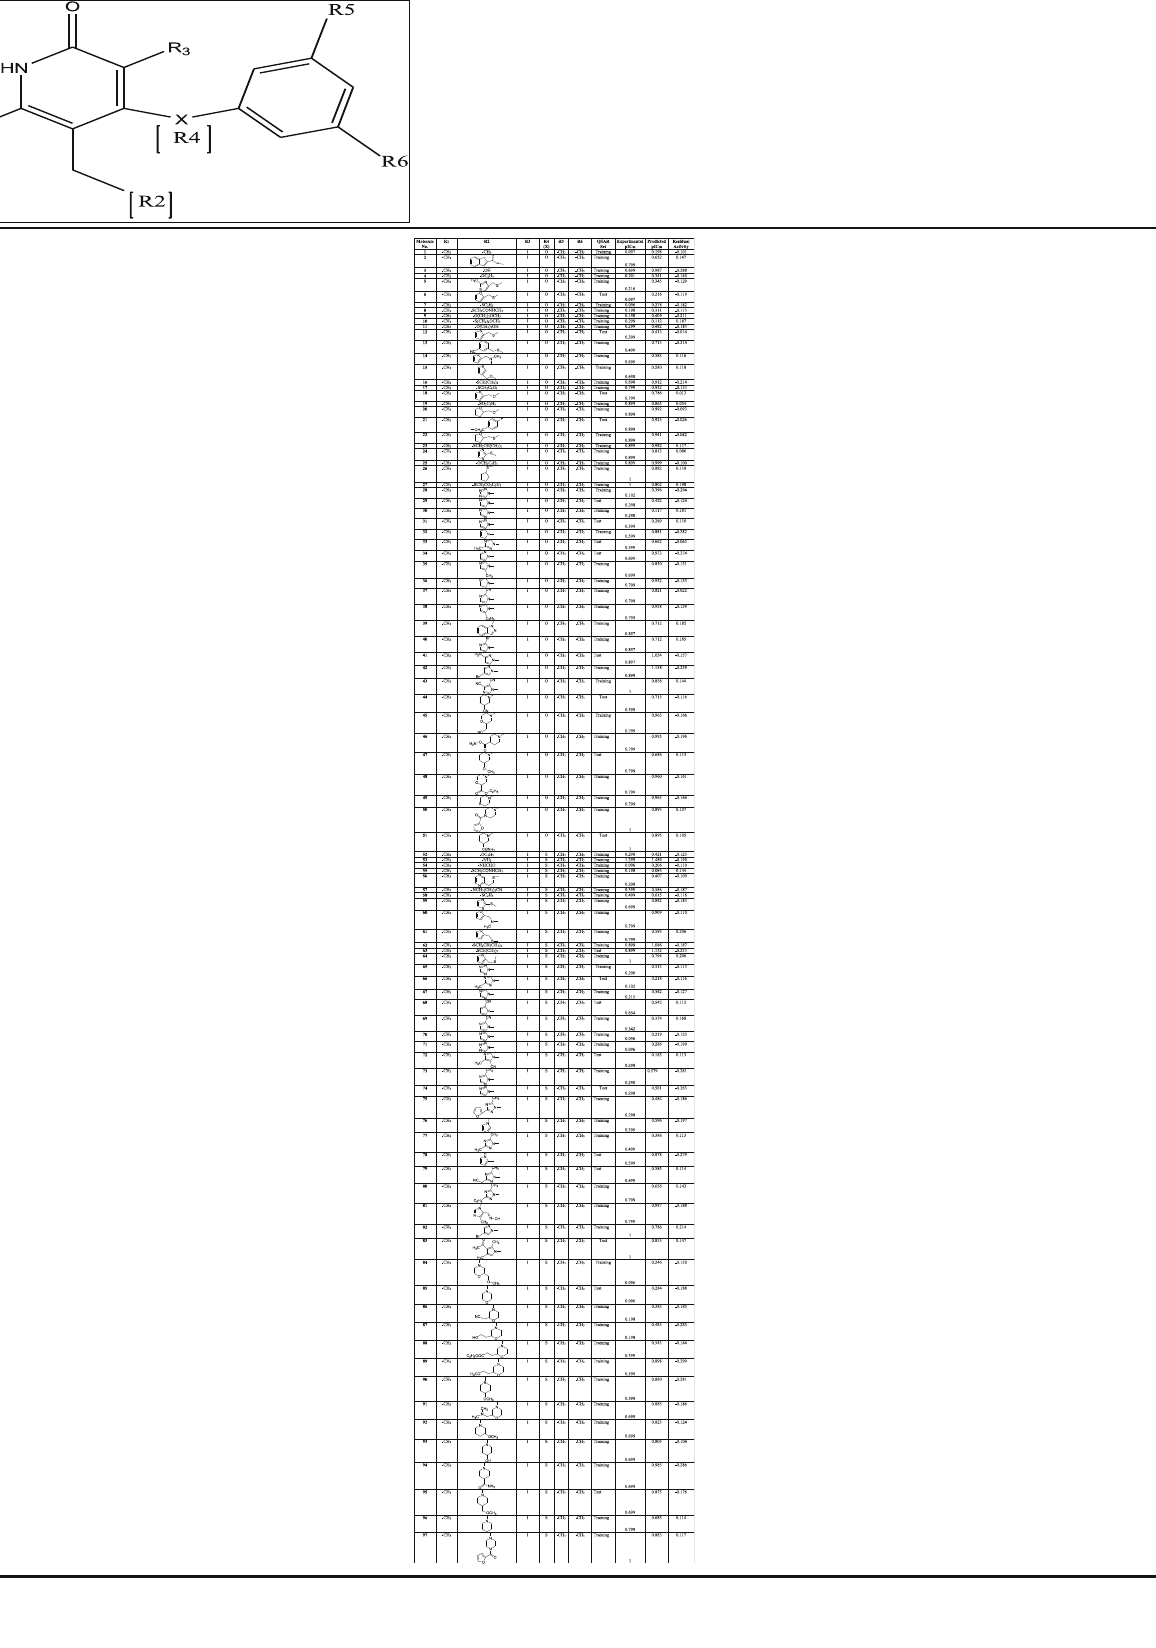
Table 1 Chemical structure and observed and predicted activities (pIC 50 ) for the training and test set